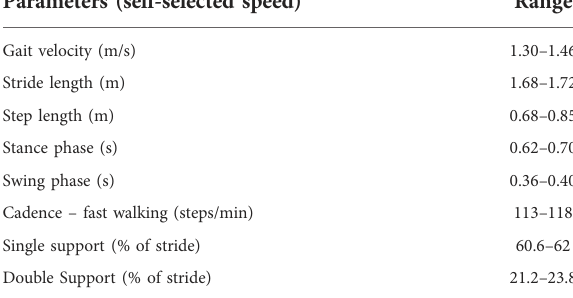
TABLE 1 Gait parameters for healthy individuals (1).